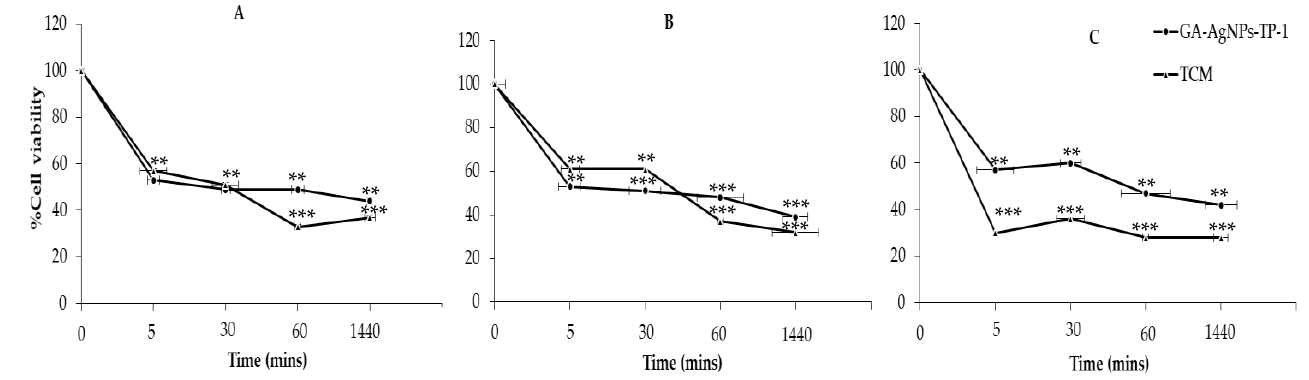
Figure 3. Cytotoxicity effects of GA-AgNPs_TP-1 compared to TCM on BMF cells. Cell viability was assessed by MTT assay after treatment with 25 ( A ), 50 ( B ) and 100 ( C ) µg/mL for various time points up to 24 h. p ≤ 0.05 was considered as statistically significant, ** p ≤ 0.01 and *** p ≤ 0.001.